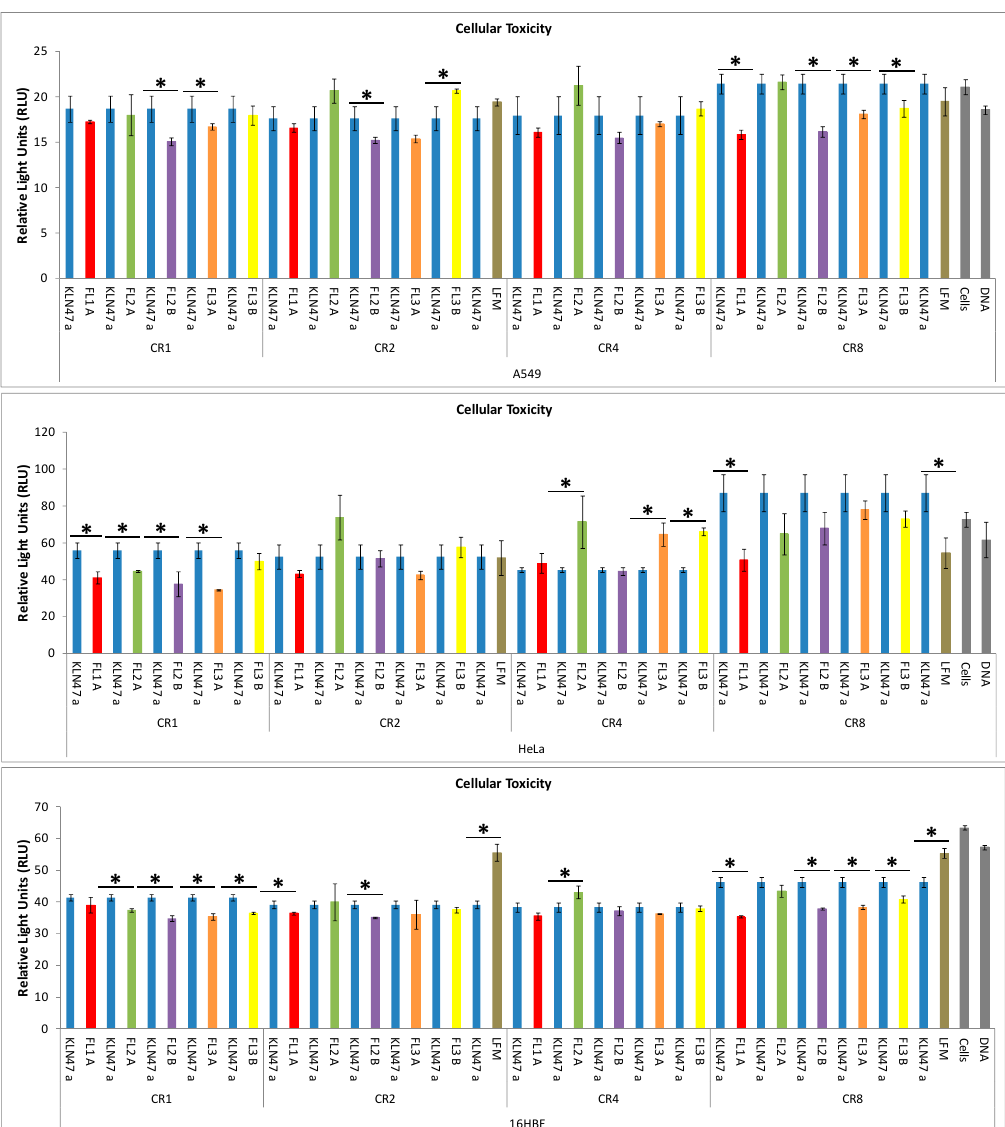
Figure 4. In vitro cytotoxicity evaluation of the different formulations into the three cell lines: A549, 16HBE and HeLa. The early cytotoxicity assessment was performed as described in experimental section, as specified by the manufacturer. The results were expressed as RLU obtained with each formulation, reflecting their cytotoxic effects as the mean ± SD of 3 wells. Asterisk (*) indicates the significance difference of gene transfection efficiency between different formulations, as determined by an ANOVA test: * p < 0.05.